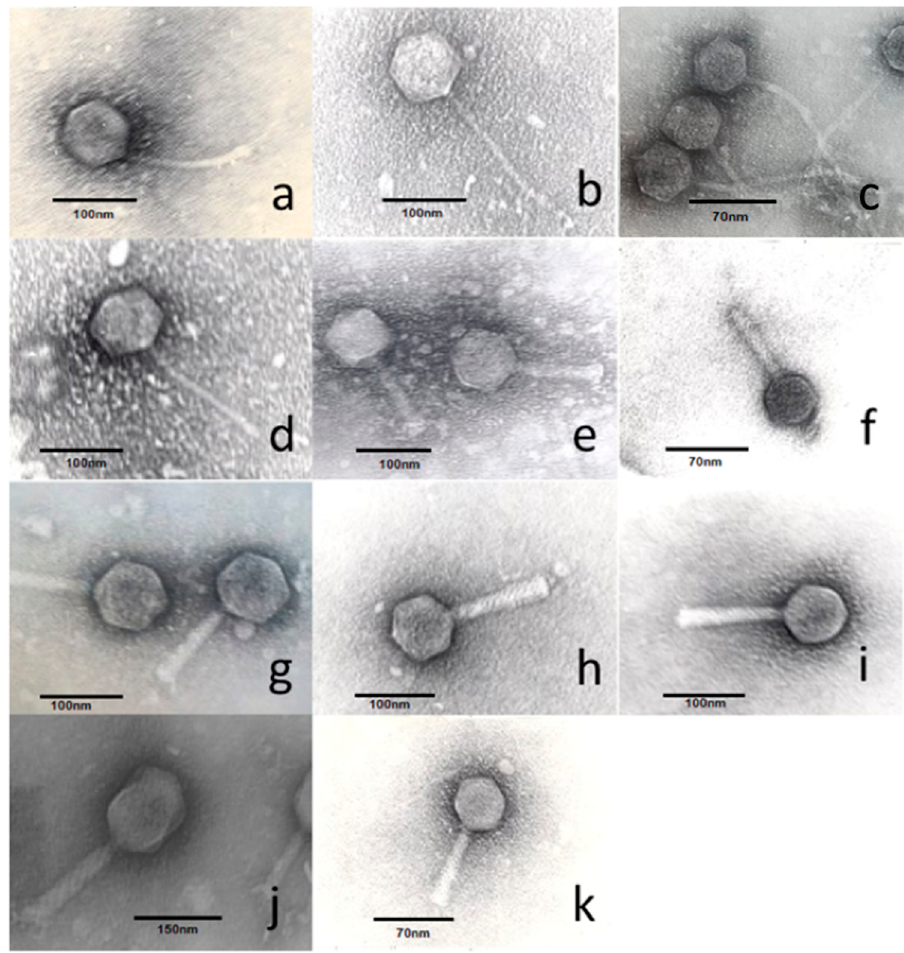
Figure 1. Transmission electron micrographs of bacteriophages used in this study. ( a ) GEC_vB_N3;